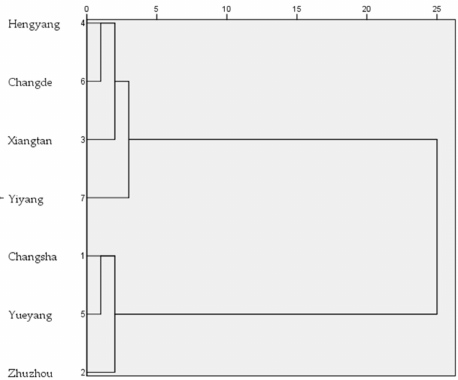
Figure 4. Cluster tree of green innovation efficiency in the Great Changsha-Zhuzhou-Xiangtan City